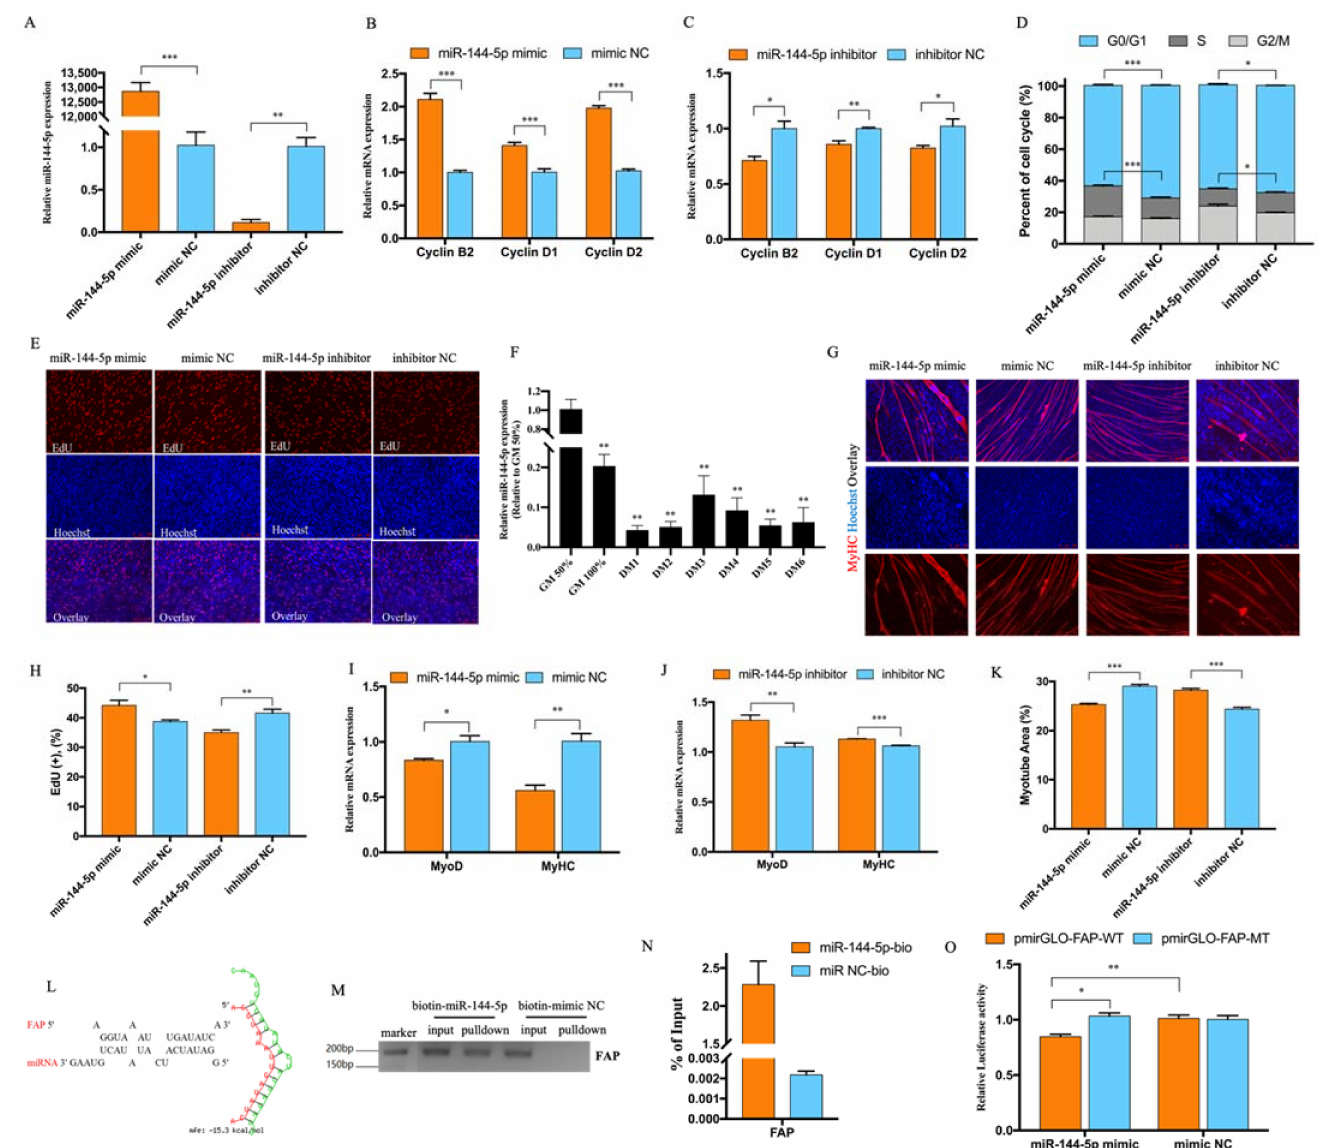
Figure 3. miR-144-5p accelerated the myoblast cell cycle and inhibited myotube formation by target- ing FAP. ( A ) miR-144-5p successfully overexpressed and inhibited in myoblast after transfected with miR-144-5p mimic and inhibitor. ( B , C ) qRT-PCR results of Cyclin B2, Cyclin D1, and Cyclin D2 after miR-144-5p overexpression and knockdown. ( D ) Cell cycle analysis after miR-144-5p overexpression and knockdown. ( E ) EdU staining and positive EdU cell rate ( H ) for myoblast cell after miR-144-5p transfection. ( F ) The relative expression of miR-144-5p during myoblast differentiation. ( G ) MyHC immunofluorescence staining of myotube and myotube area percentage ( K ) after miR-144-5p trans- fection. ( I , J ) qRT-PCR results of MyoD and MyHC after miR-144-5p transfection. ( L ) RNAhybrid software analysis the potential binding site between miR-144-5p and FAP. ( M , N ) Biotin-labeled miRNA pulldown revealed the interaction between miR-144-5p and FAP. ( O ) The dual- luciferase reporter assay was performed by co-transfecting pmirGLO-FAP-WT/MT plasmid with miR-144-5p mimic or mimic NC. (* p < 0.05; ** p < 0.01, *** p <